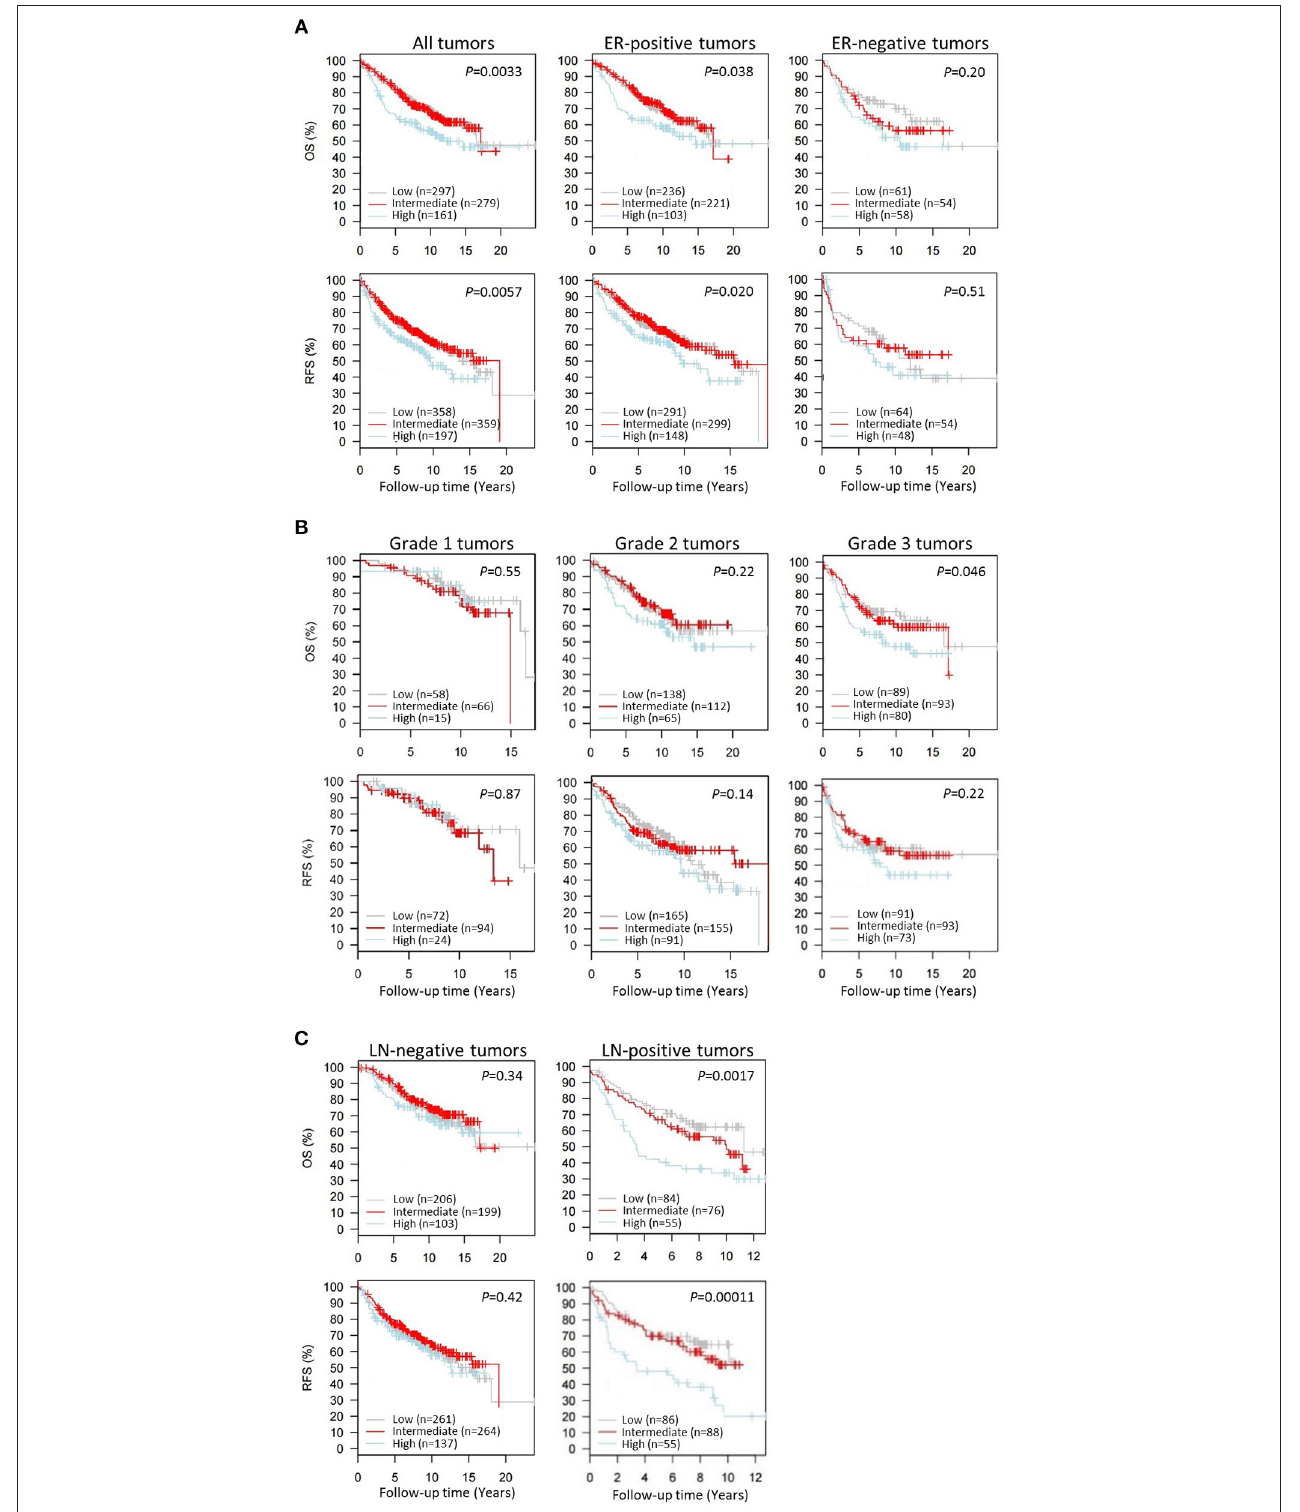
FIGURE 7 | Kaplan-Meier survival analyses of the resistin receptor CAP1 expression in relation to overall survival (OS) or relapse-free survival (RFS) in the 1,881-sample GOBO breast cancer data set. Graphs show associations of CAP1 , categorized into tertiles based on the CAP1 gene expression levels low, intermediate or high, with breast cancer outcomes. Percent OS or RFS (A) among all patients or according to tumor ER-status (positive/negative), and in relation to (B) tumor grade 1–3 or (C) lymph node involvement (LN-negative/positive) among all patients. Log-rank (2 df) P -values are shown, and number of patients in each tertile are indicated.